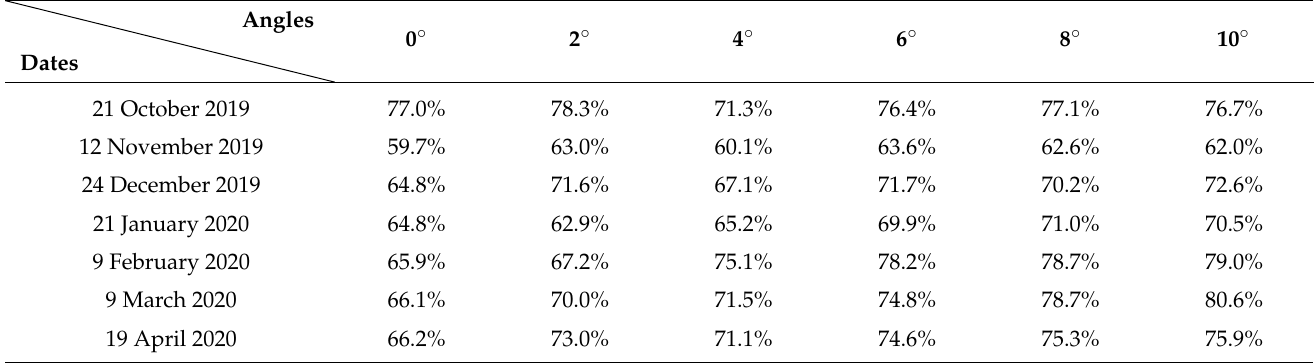
Table 8. Overall accuracies of the top multi-feature combinations at small incidence